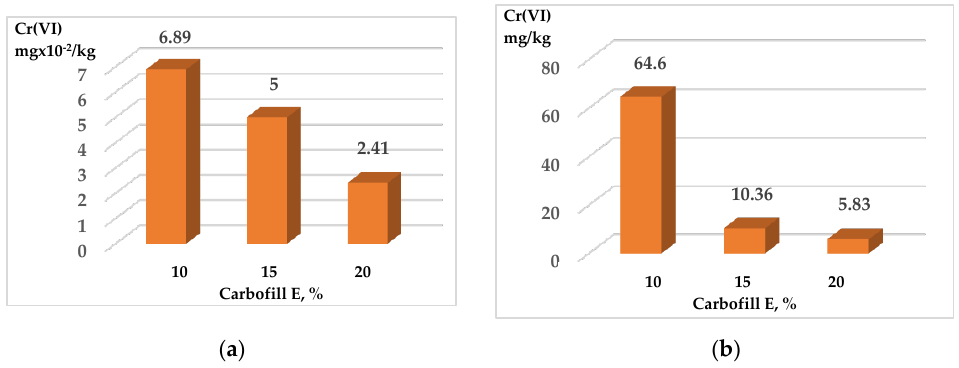
Figure 6. Washing out of chromium compounds from SCS sandy samples with immobilized Cr (VI) 3000 mg/kg and various amounts of Carbofill E. Samples: uncrushed—( a ); crushed—( b ).